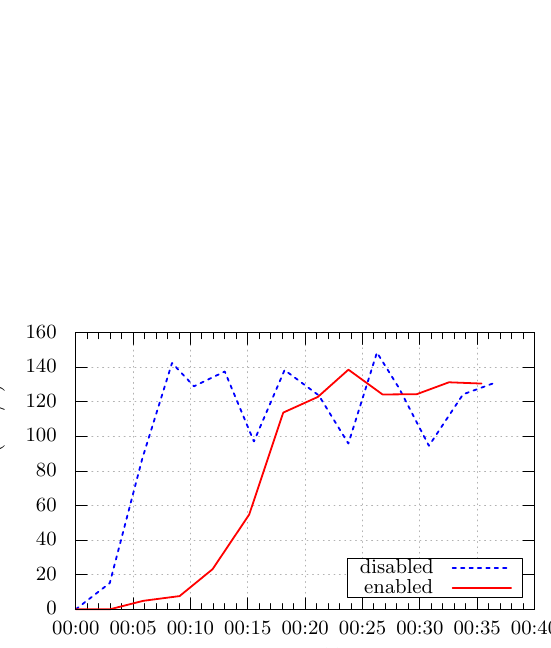
Figure 7: Visualization of network usage (top graph) and power consumption (bottom graph) while machines are turned off and on